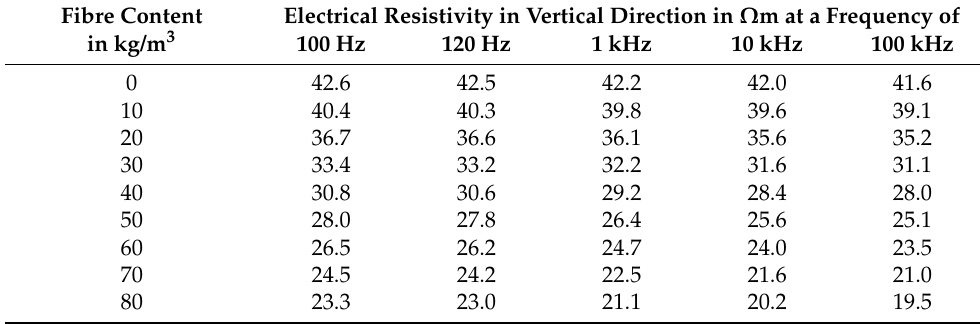
Table A25. Results of the resistivity measurements of the concrete mixture 32-60-300-00-F2.